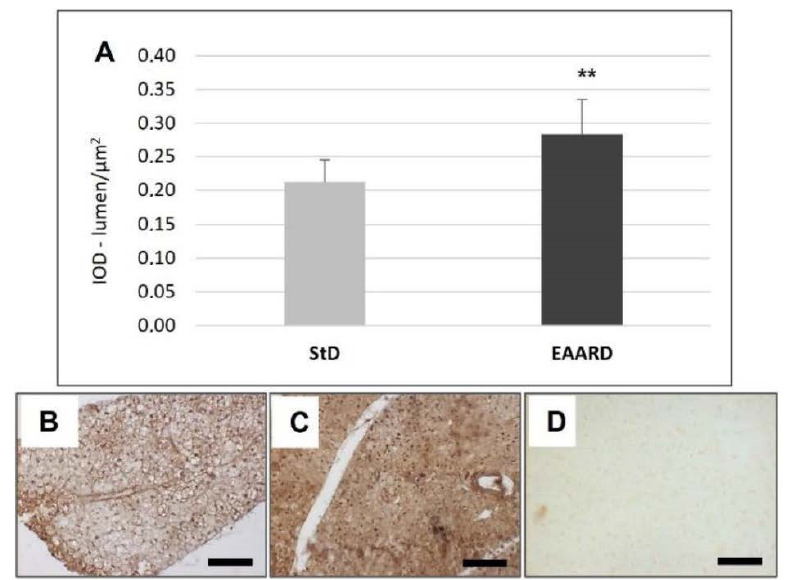
Figure 11. ( A ): Optical density for UCP-1 immunostaining in BAT ( t = 3.352, p = 0.000) according to diet (mean ± sd). ** p < 0.01. ( B , C ): Representative images of BAT IHC in StD and EAARD-fed mice, respectively. ( D ): Negative control performed by omitting the primary antibody. Original magnification 20 × ; scale bar 50 µ m.